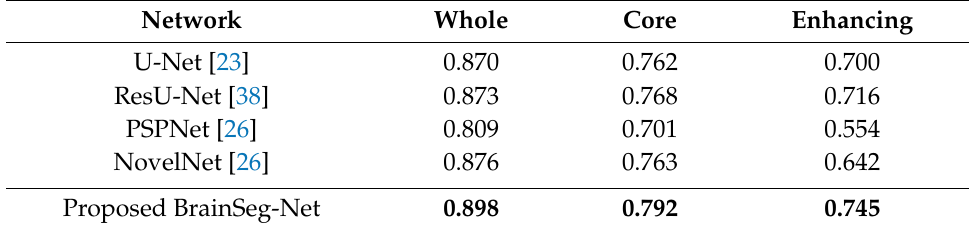
Table 3. Results comparison on the BraTS 2017 validation